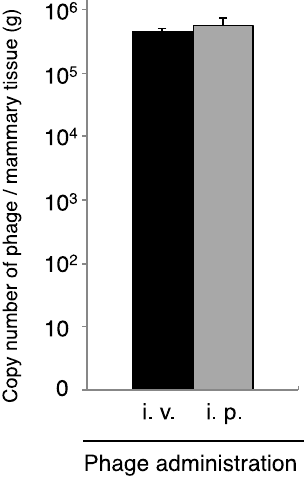
Figure 3. Transition of phage to the mammary gland by intravenous or intraperitoneal Φ SA012 administration. Mammary glands were separated at 30 min after phage administration (4 × 10 7 PFU) through the intravenous (i.v., n = 13) or intraperitoneal (i.p., n = 14) route. Total DNA containing phage, host cells was purified from the mammary glands, and then phage copy numbers were determined by real-time PCR, using phage-specific primers. Bars indicate standard errors of the means. There was no statistically significant difference.